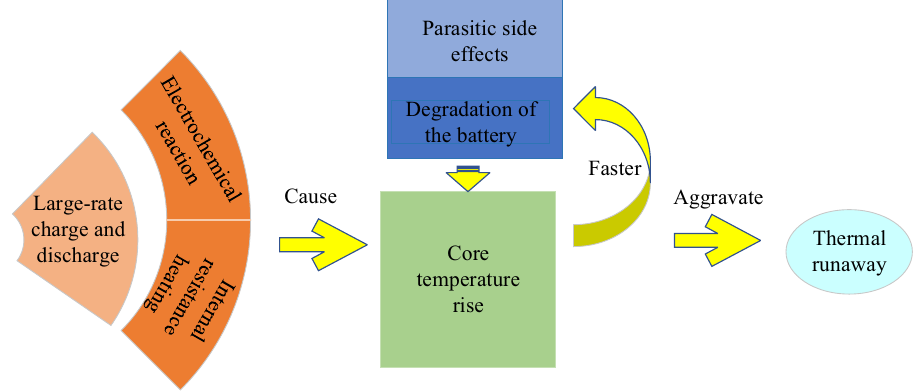
Figure 1. The cause and influence of the rise of core